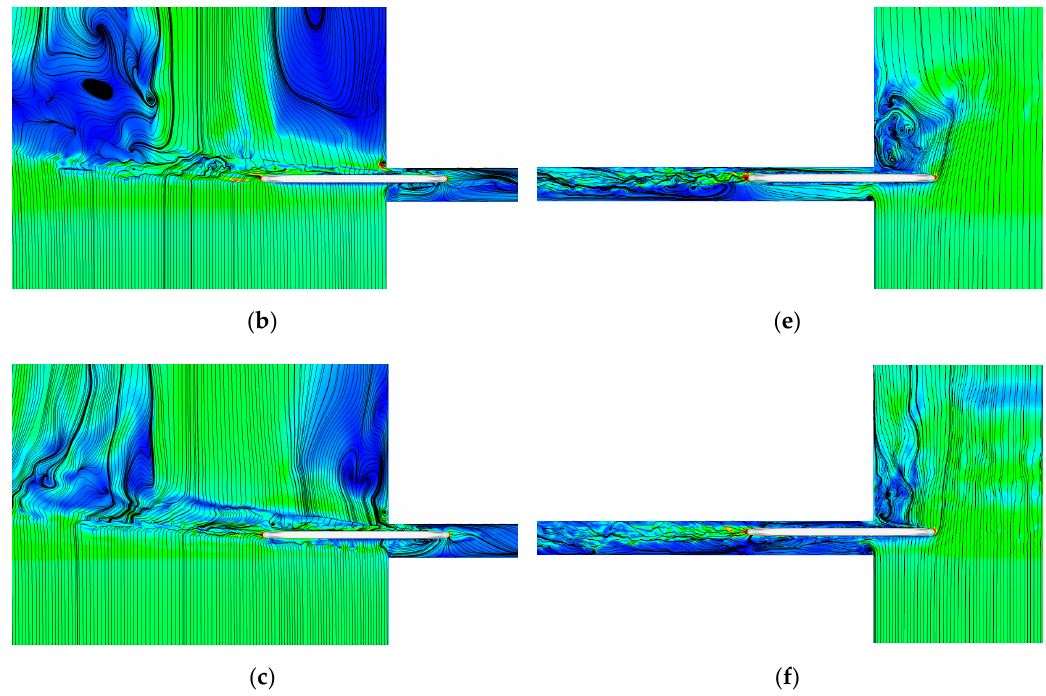
Figure 17. Streamlines and velocity distributions. ( a ) Case 1 at t 2 = 1.285 s; ( b ) Case 2 at t 2 = 1.285 s; ( c ) Case 3 at t 2 = 1.285 s; ( d ) Case 1 at t 6 = 4.369 s; ( e ) Case 2 at t 6 = 4.369 s; and ( f ) Case 3 at t 6 = 4.369.